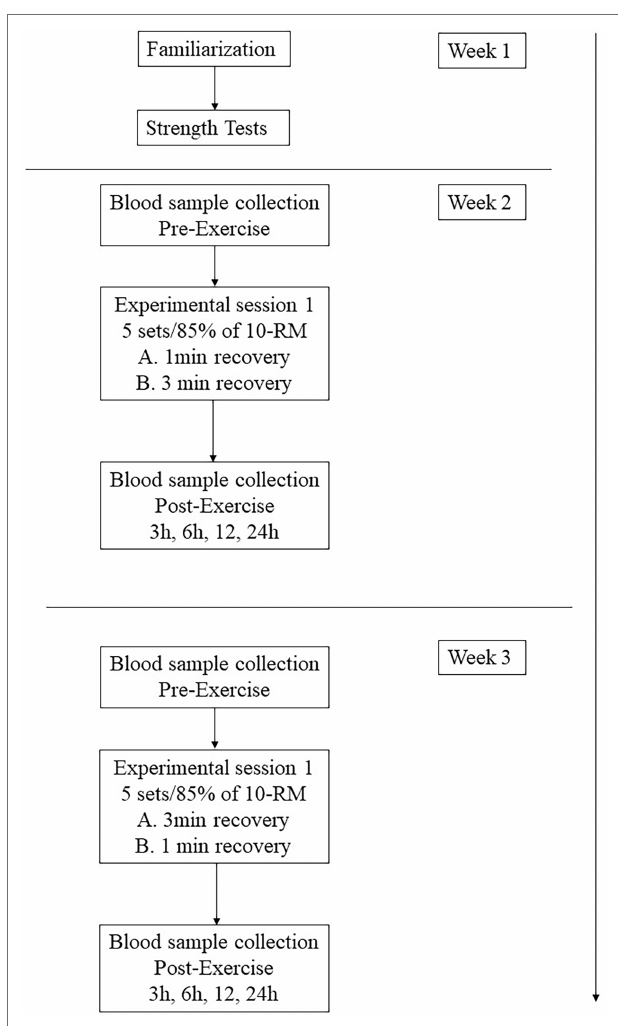
FIGURE 1 | Flowchart of the experimental approach to the